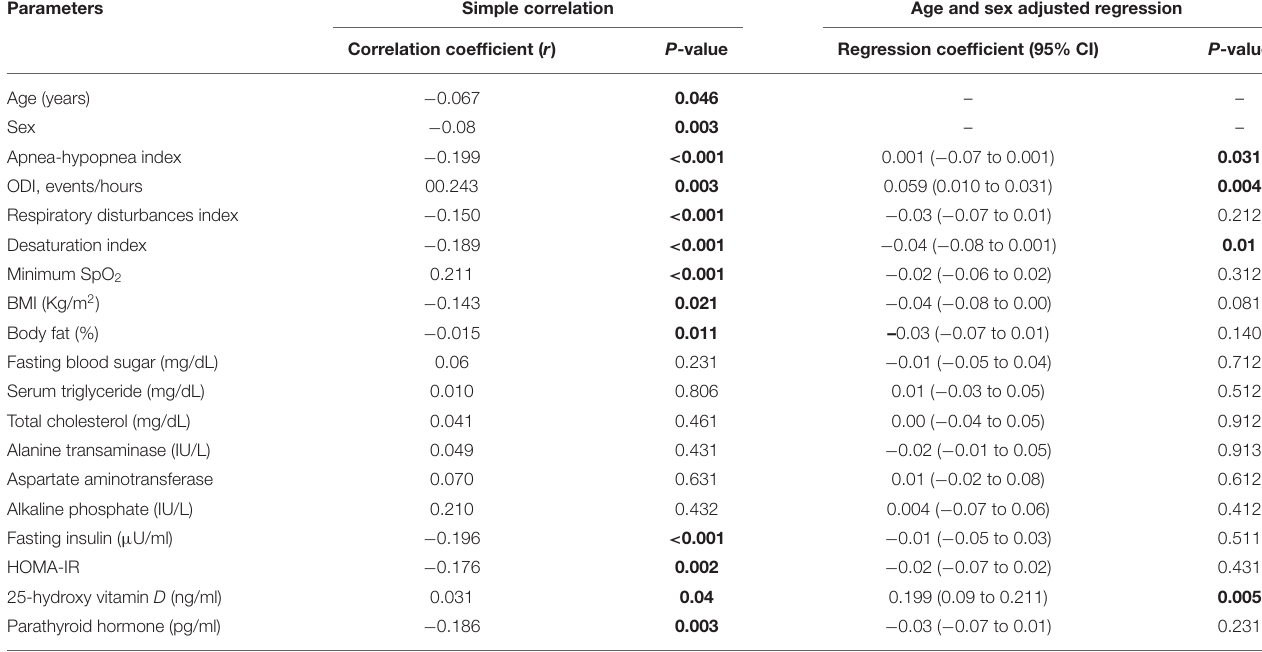
TABLE 2 | Univariate and bivariate analyses to identify factors associated with telomere length. Parameters